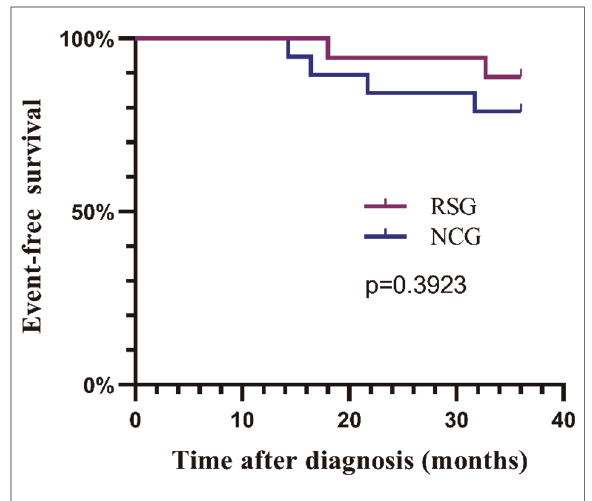
FIGURE 3 The 3-year event-free survival curves for the RSG and NCG. RSG, routine surgery group; NCG, neoadjuvant chemotherapy